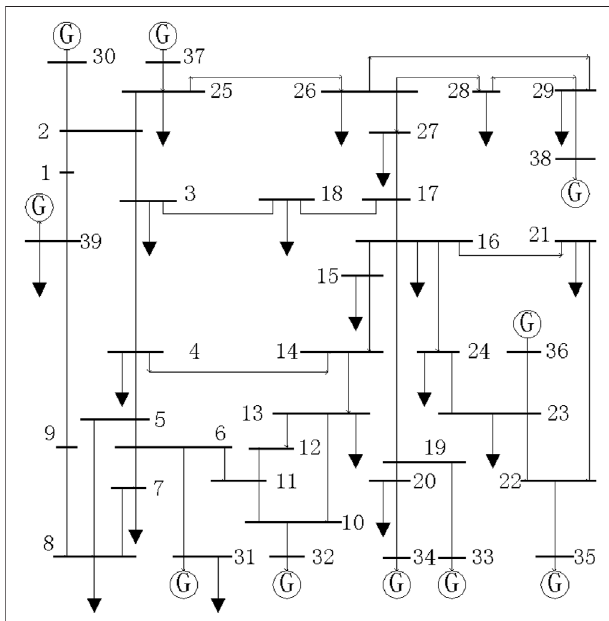
FIGURE 5 | The IEEE 39-bus power